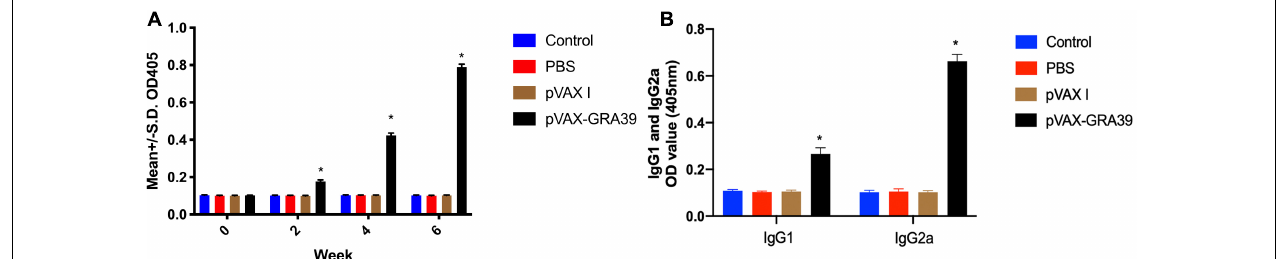
FIGURE 3 | Detection the levels of total IgG, IgG1 and IgG2a antibodies in the sera of Kunming mice. (A) Determination of IgG titers induced by DNA immunization at weeks 0, 2, 4, 6. (B) Determination of IgG1 and IgG2a titers in the sera of mice two weeks after the last immunization. The results were expressed as means ± SD ( n = 3) with respect to absorbance at OD450 and statistical differences ( p < 0.05) are indicated by (*). The bars represented the levels of IgG, IgG1, and IgG2a in the serum of mice.